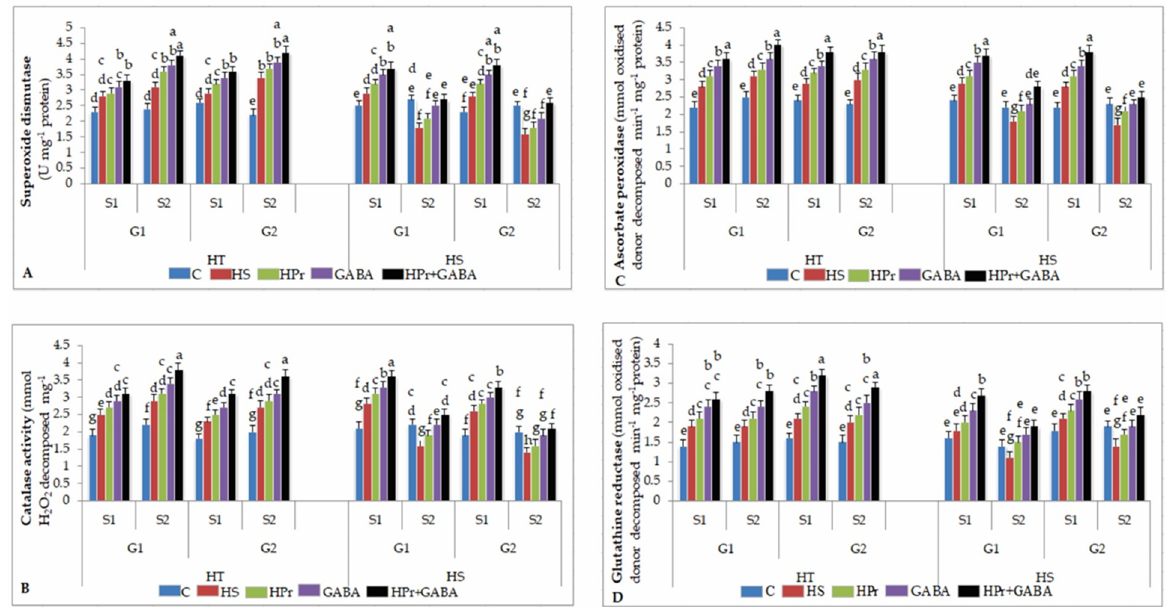
Figure 6. Effect of heat priming (HPr) and γ -amino butyric acid (GABA), applied individually or in combination (HPr+GABA) on superoxide dismutase ( A ), catalase ( B ), ascorbate peroxidase ( C ) and glutathione reductase ( D ) activities on heat-tolerant (G1: IG2507; G2: IG3263) and heat-sensitive (G1: IG2821; G2: IG2849) genotypes at stage 1 (S1) and stage 2 (S2) in heat-stressed (HS) lentil plants, compared to control ( C ). Vertical bars represent standard errors ( n = 3). Different small letters on the bars indicate significant differences from each other ( p < 0.05). LSD for interaction (genotypes × stages × treatments) ( p < 0.05): superoxide dismutase: 0.21, catalase: 0.19; ascorbate peroxidase: 0.20, glutathione reductase: 0.19.